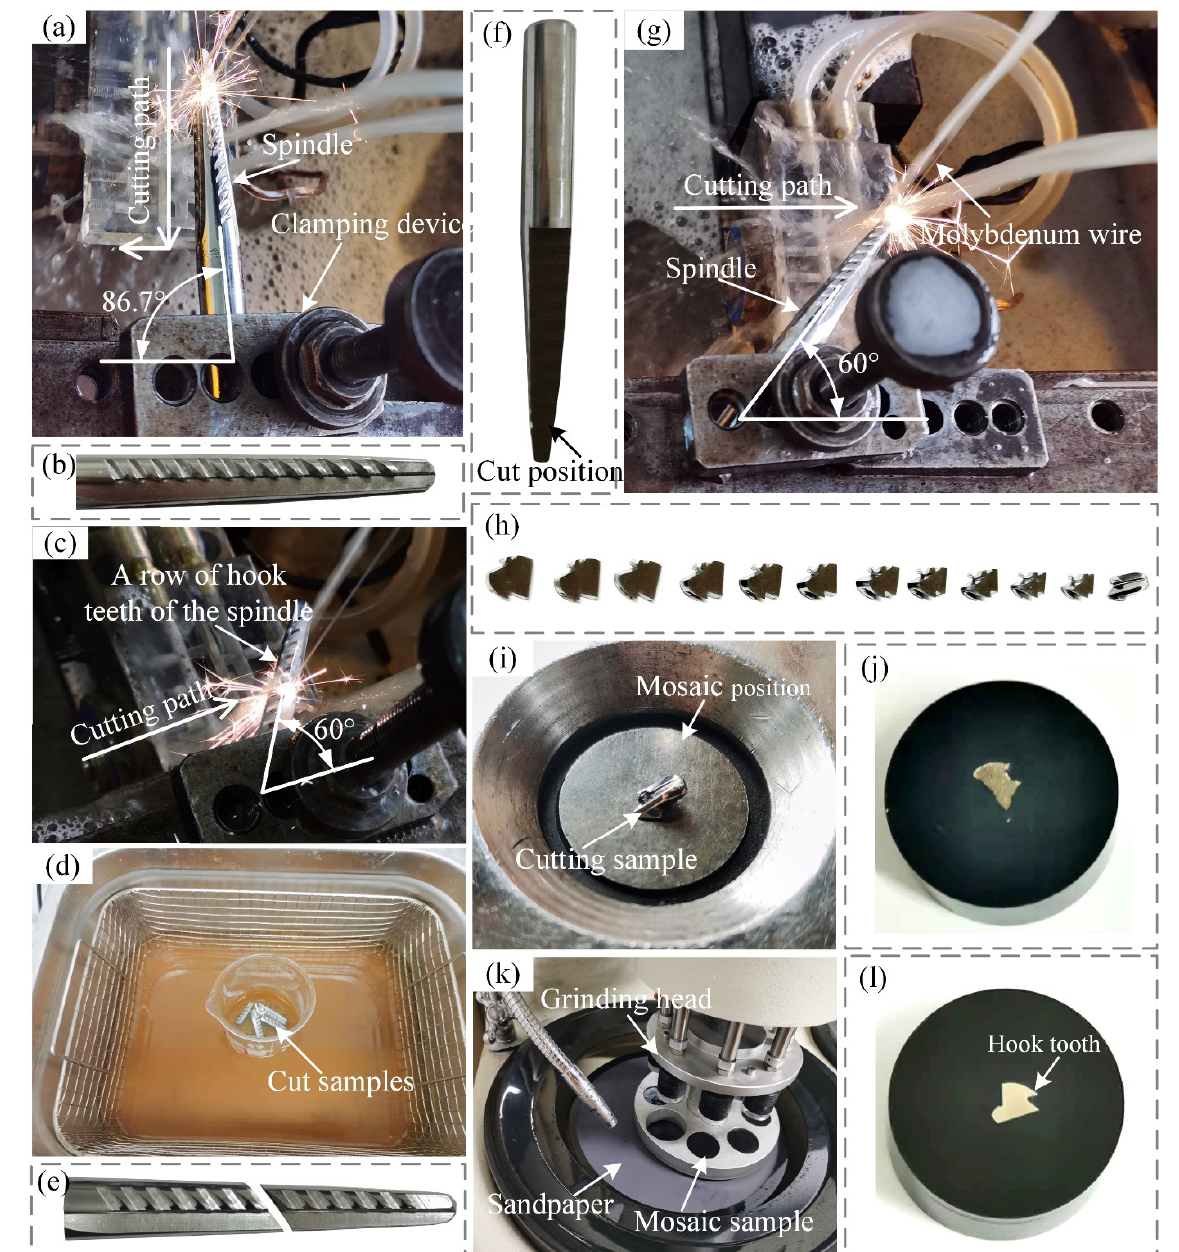
Figure 2. Cutting and sample preparation process: ( a ) first wire cutting process; ( b ) row of hook teeth of the spindle; ( c ) second wire cutting process; ( d ) ultrasonic cleaning process; ( e ) surface samples of the hook teeth; ( f ) spindle sample after the first cutting; ( g ) third wire cutting process; ( h ) cut samples; ( i ) mosaic process; ( j ) mosaic sample; ( k ) grinding and polishing processes; and ( l ) cross-section samples of the hook teeth.